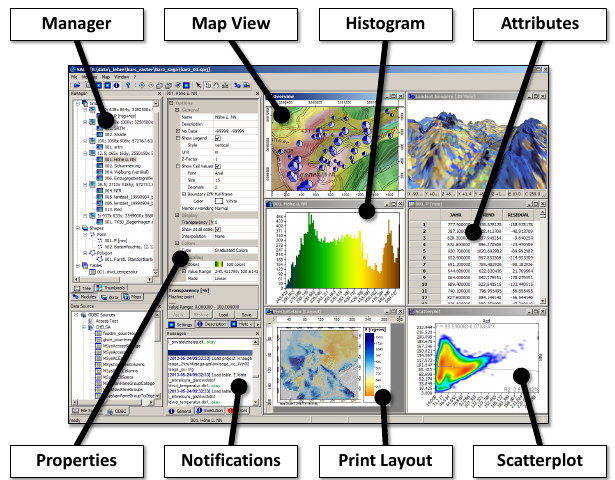
Figure 7. Graphical user